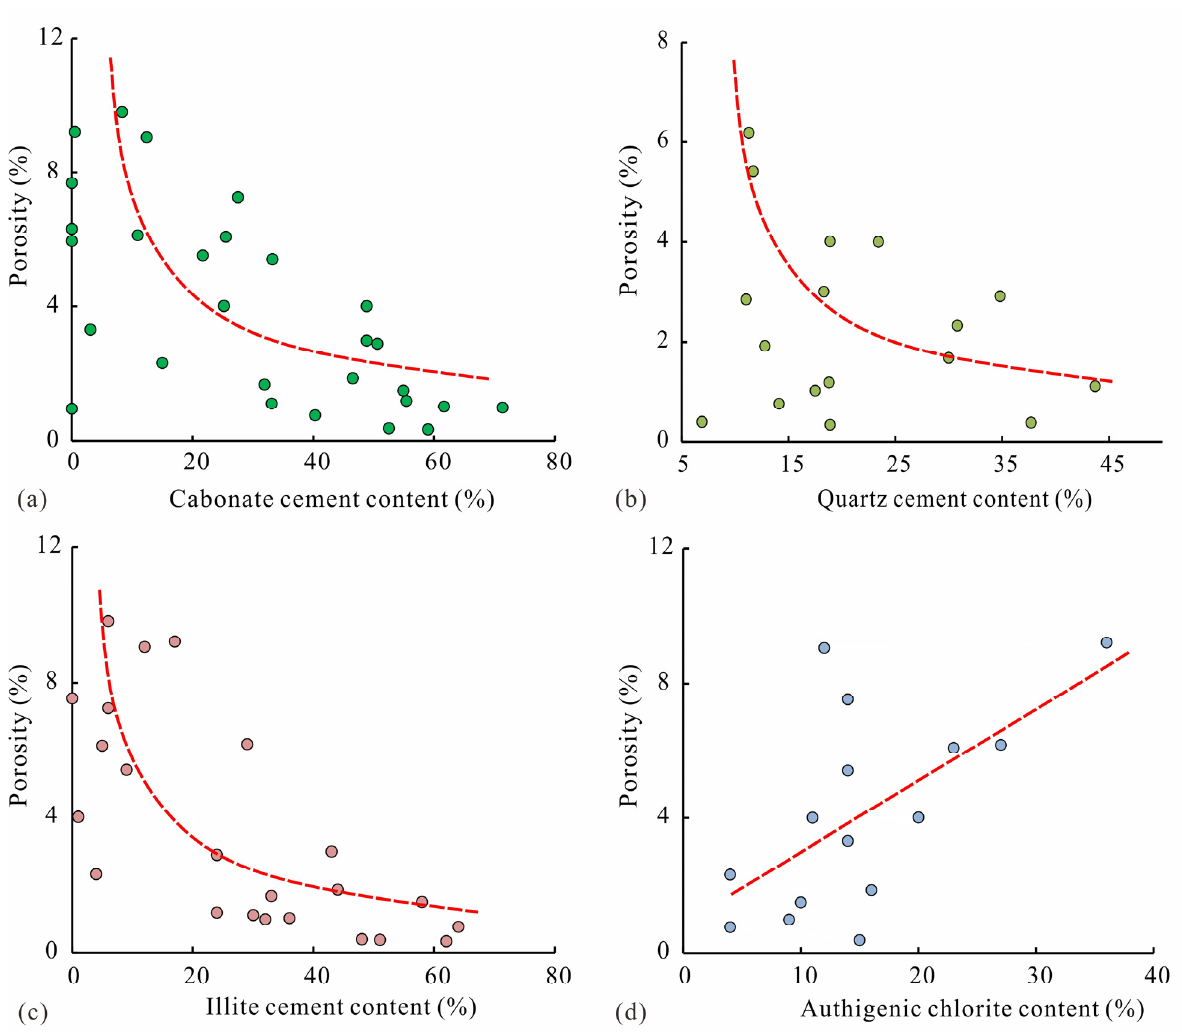
Figure 11. ( a ) Porosity and carbonate cement content. ( b ) Porosity and quartz cement content. ( c ) Porosity and illite content. ( d ) Porosity and authigenic chlorite content.